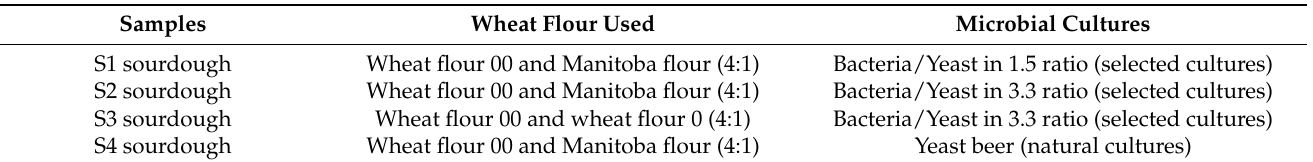
Table 1. Sourdough